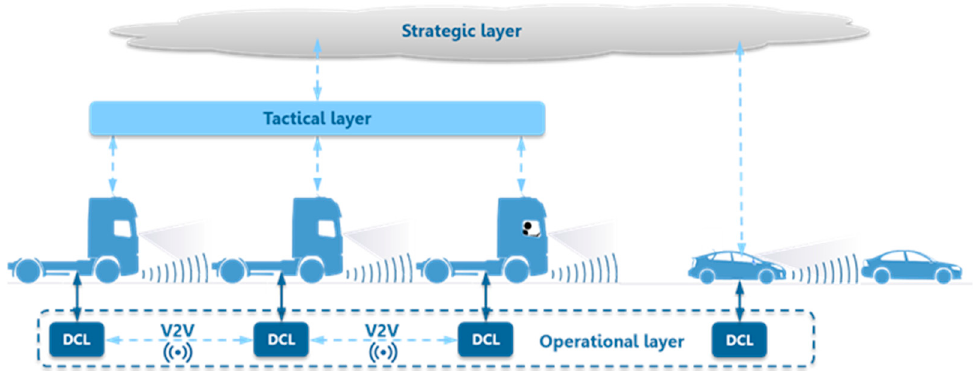
Figure 1. Both V2V communication in an operational layer and tactical layer between vehicles in a V2V enabled platoon, and I2V communication between infrastructure and individual vehicles in a strategic layer, according to the Horizon 2020 ENSEMBLE project [18].